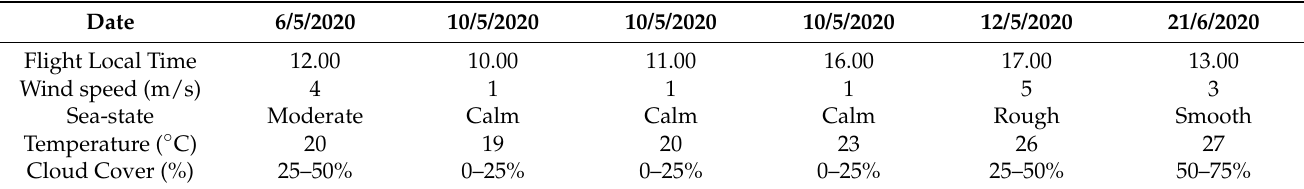
Table 1. Flight conditions during the UAS surveys.